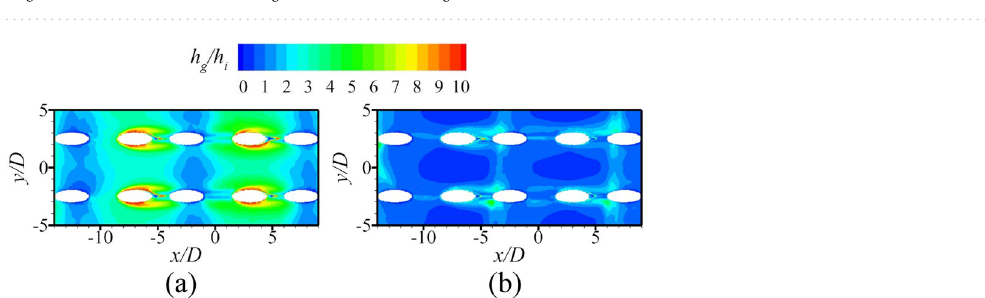
Figure 27. Contours of Bi g and h g / h i with different Re g (left: Re g = 2900; middle: Re g = 3300 (Ref-case #1); right: Re